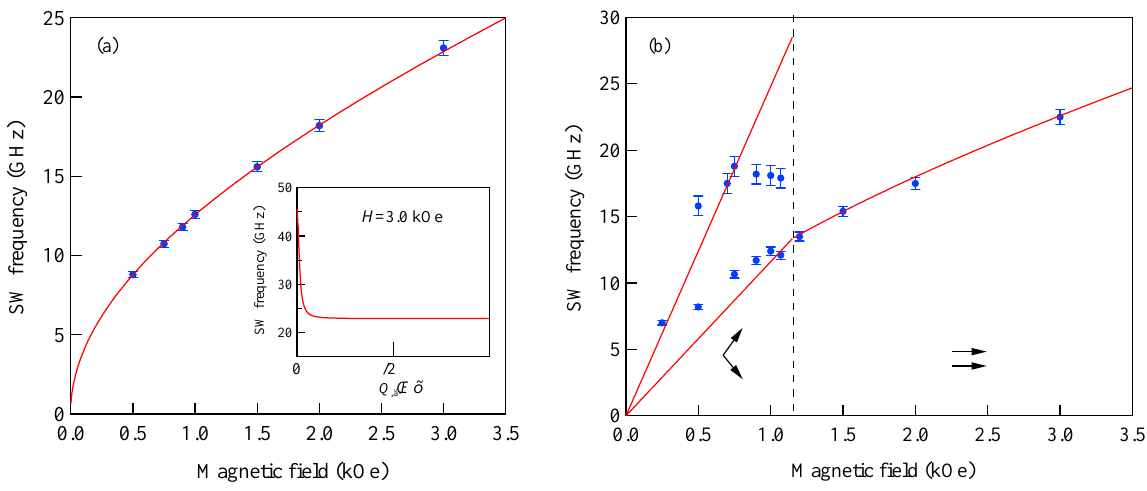
Figure 25. ( a ) SW frequencies as a function of the magnetic field for the [Fe(30 Å)/Cr(21 Å)] MML. The solid lines show the calculated SW frequencies by using Equation (151) with Q // = 0.67 × 10 5 cm γ /2 π = 2.88 GHz/kOe, and 4 π M = 18.0 kG. The inset shows the SW frequencies as a function of the Q // Λ parameter. ( b ) SW frequencies as a function of the magnetic field for [Fe(30 Å)/Cr(13 Å)] MML. The solid lines were calculated by using Equations (162)–(164) below H = 1.15 kOe and by Equation (151) above H = 1.15 kOe